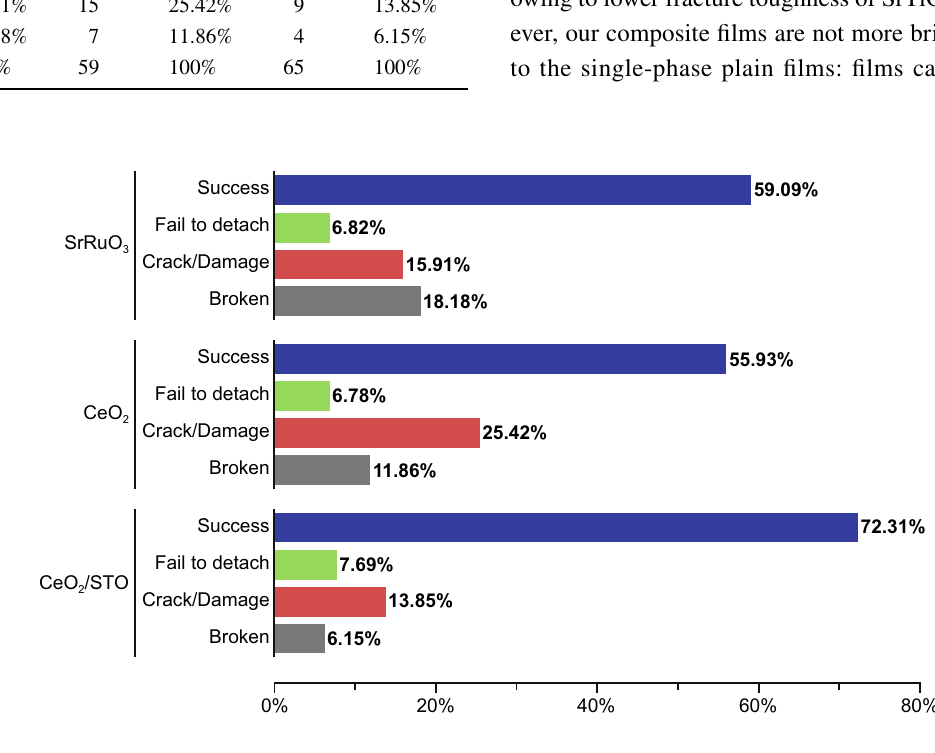
Fig. 8 Distribution of different result types from each thin film